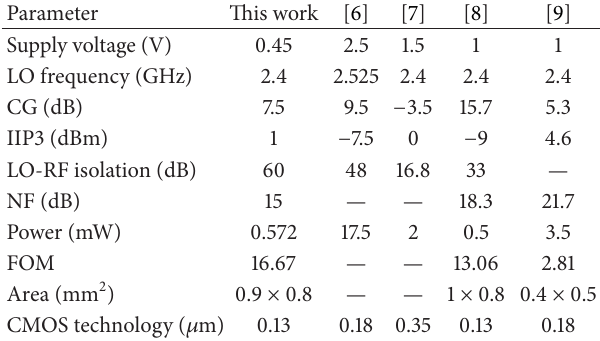
Table 2: Performance summary and